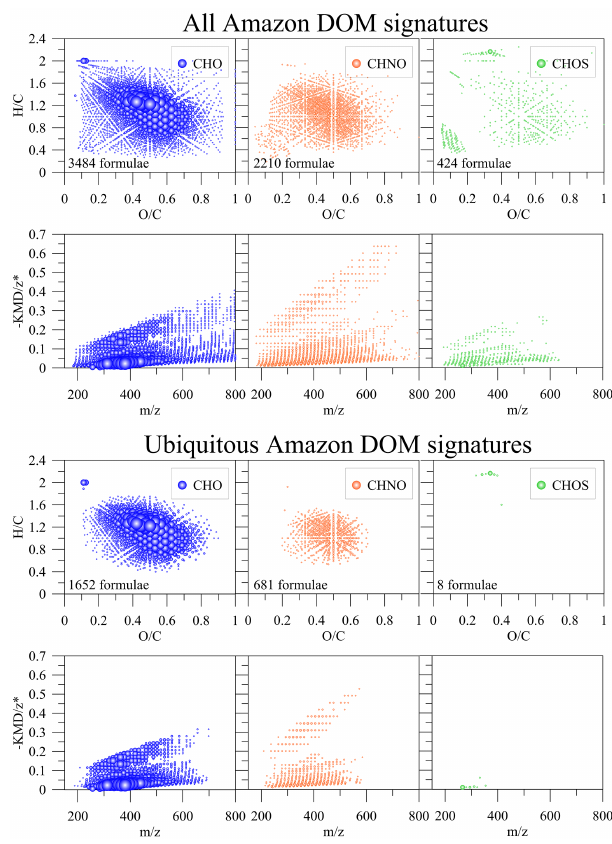
Figure 2. Van Krevelen diagrams of the total and the ubiquitous m/z ions in all Amazon SPE-DOM samples analyzed by FT-ICR-